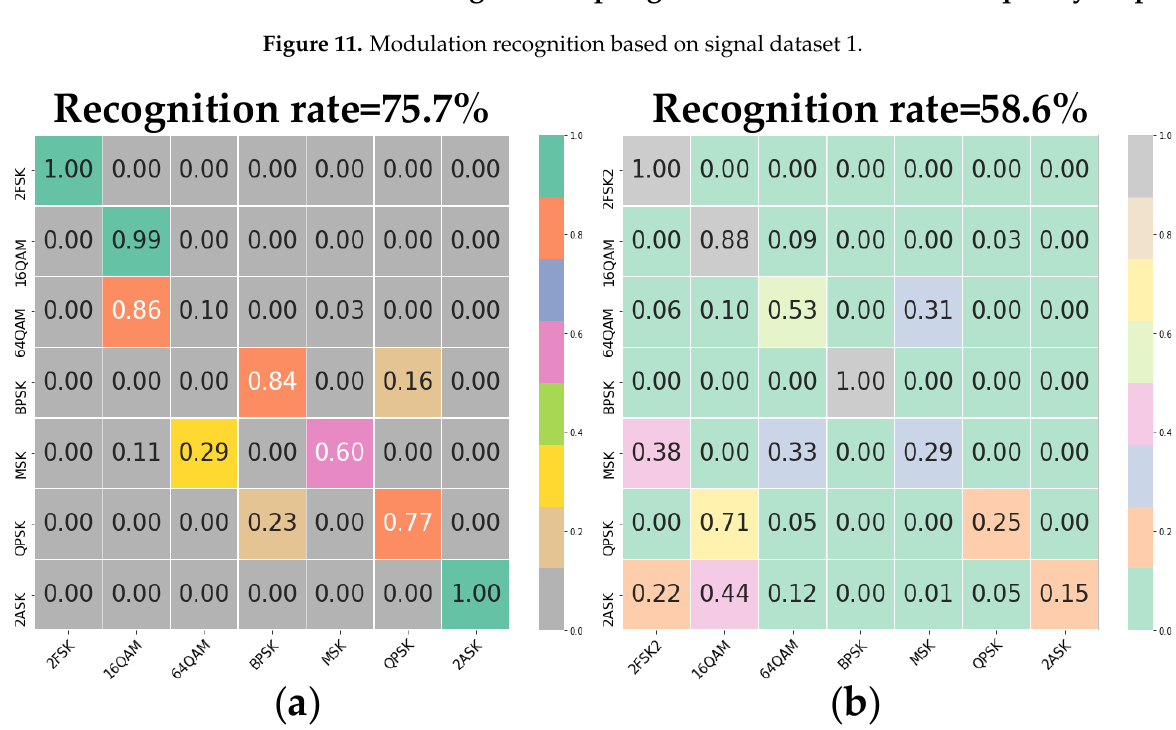
Figure 12. Experimental results on signal dataset 2 in which the signal parameters to be recognized are inconsistent with those of the training set. ( a ) Original sampling waveform. ( b ) Time-frequency map.